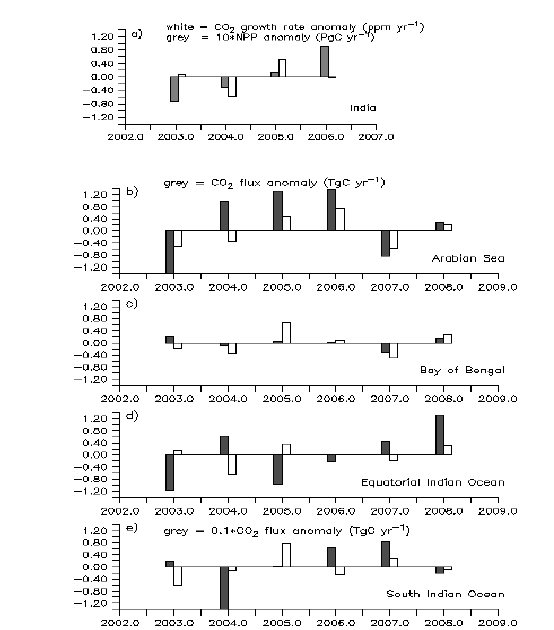
Figure 6. Comparison between anomaly of atmospheric CO 2 growth rate (ppm y -1 ) and anomaly of surface CO 2 fluxes over India (in form of NPP in gC m -2 y -1 ) and over different basins of the Indian Ocean during different years of the study period. The NPP anomaly shown in the figure is presented in an enhanced scale (i.e. 10 times larger) and fluxes over south Indian Ocean are presented in a reduced scale (10 times smaller than the actual